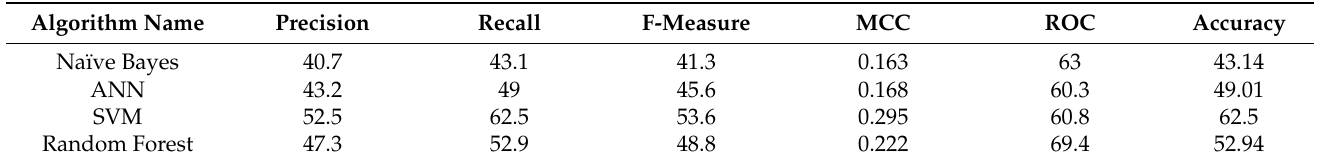
Table 9. Comparison among classification algorithms using 10-fold cross-validation testing to predict the total critical cases.